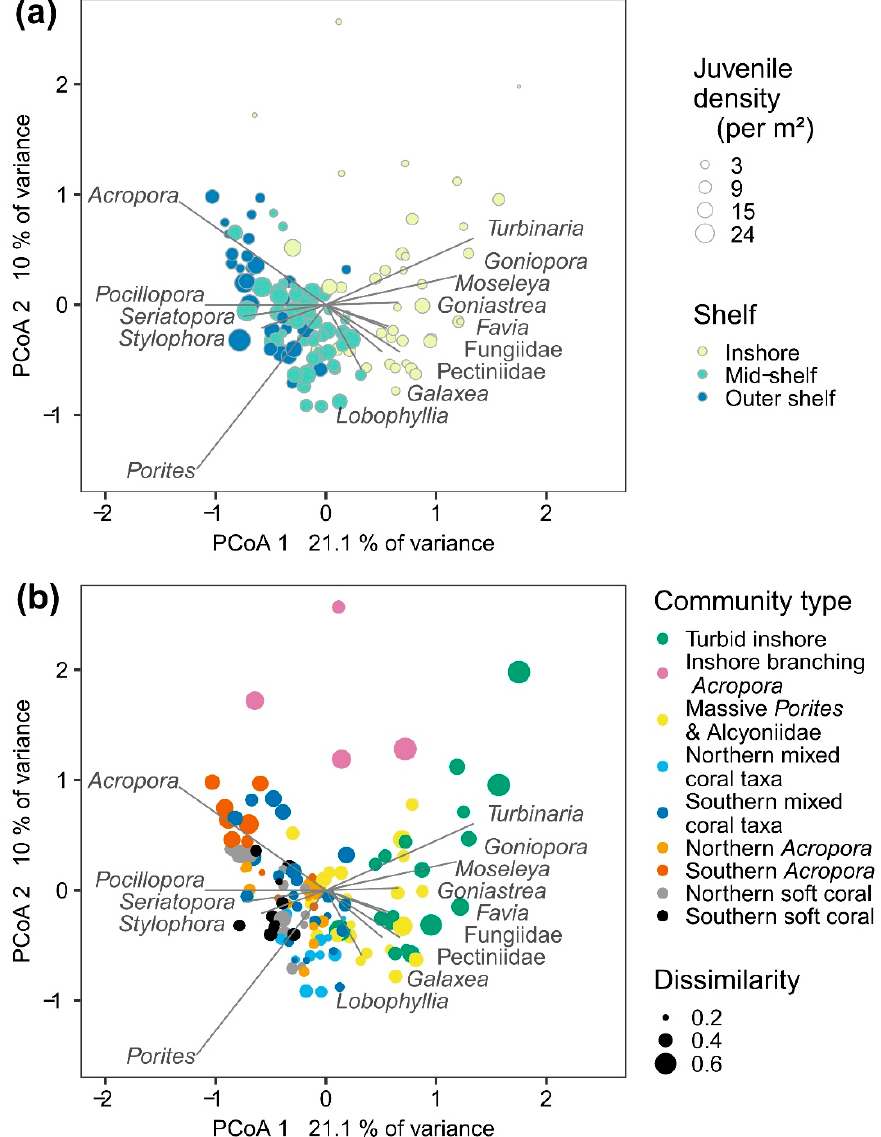
Figure 3. Principal coordinate analysis (PCoA) ordination plots using Bray–Curtis dissimilarity of juvenile coral assemblages for 122 reefs; ( a ) position across the continental shelf are represented by color and the juvenile densities per reef are represented by circle diameter, ( b ) community types classified by composition of adult communities, at their relative cover of coral taxa at maximum coral cover, are represented by color and dissimilarity distances are represented by circle diameter.